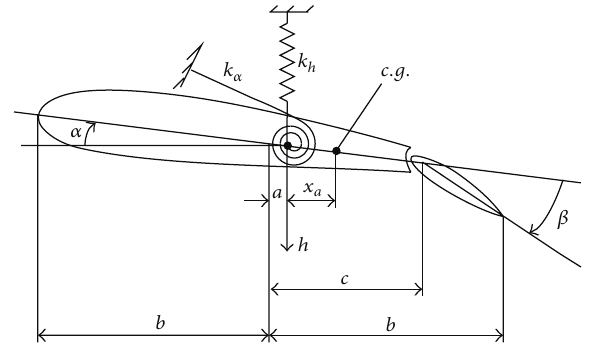
Figure 1: Aeroelastic